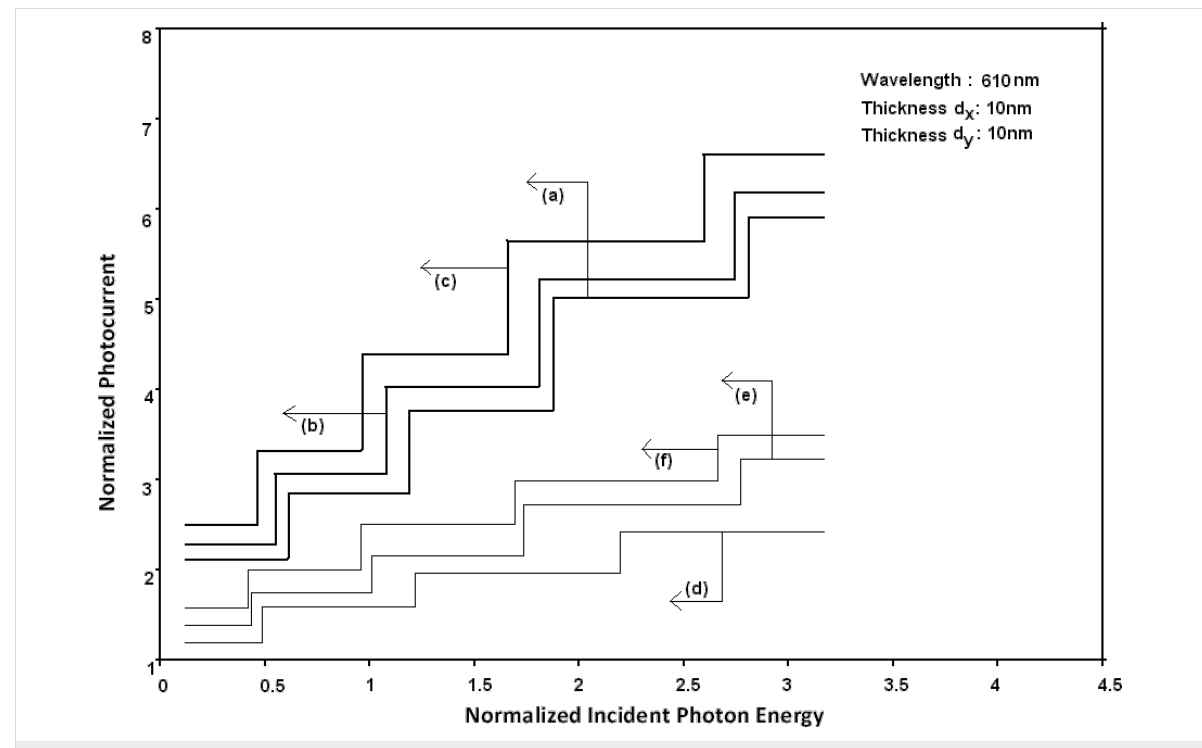
Figure 10: Plot of the normalized photocurrent as a function of normalized incident photon energy from quantum well wire effective mass superlat- tices of HgTe/Hg 1 − x Cd x Te and In x Ga 1 − x As/InP for all cases of Figure 6.